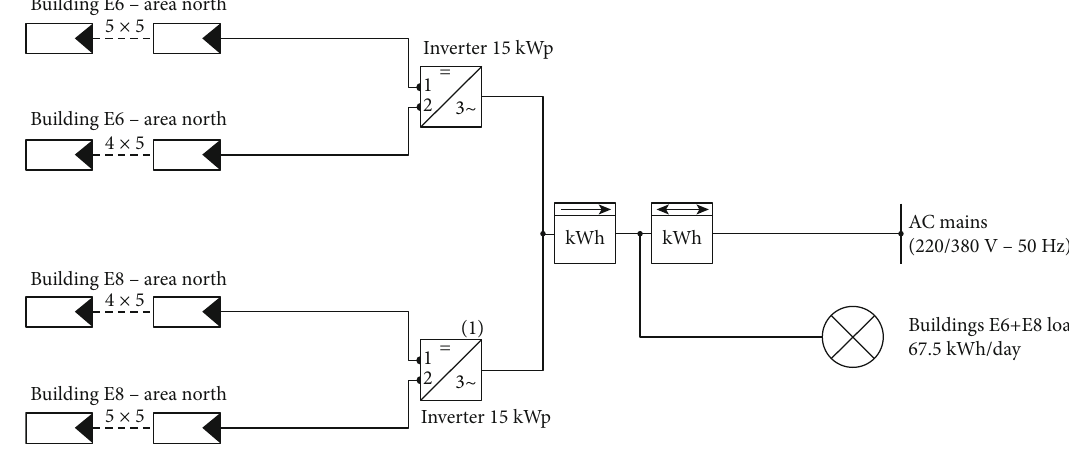
Figure 13: Schematic design of BAPV system connected to the grid for E6+E8